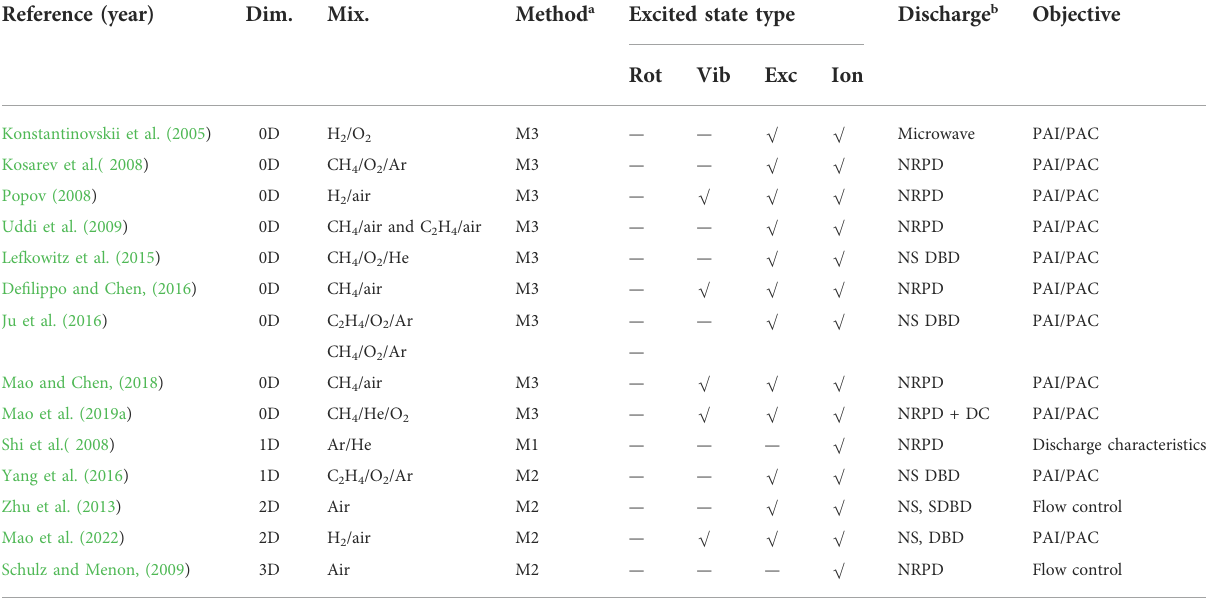
TABLE 1 Summary of simulations involving nonequilibrium plasma.